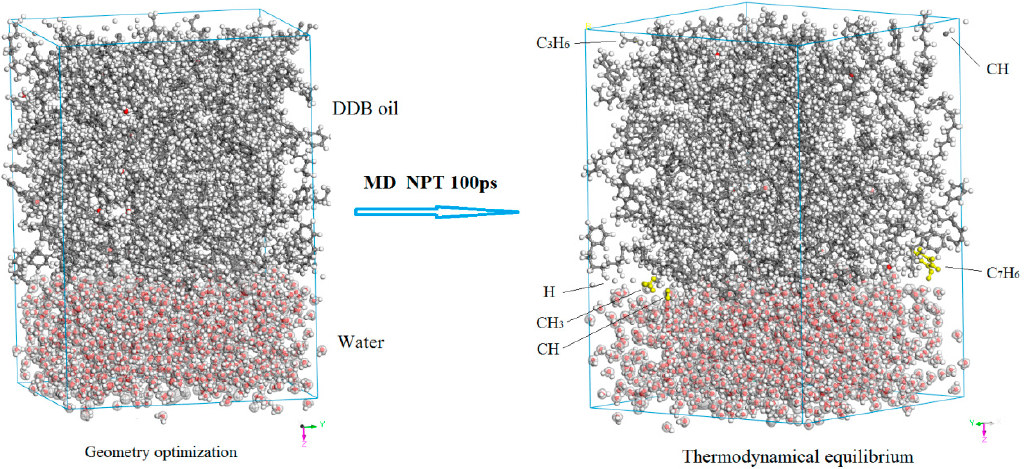
Figure 6. Morphological structures of H 2 O − /DDB two ‐ phase system at 300 K temperature and 200 kV/m electric field before and after reaching thermodynamic equilibrium from molecular dynamics simulation.